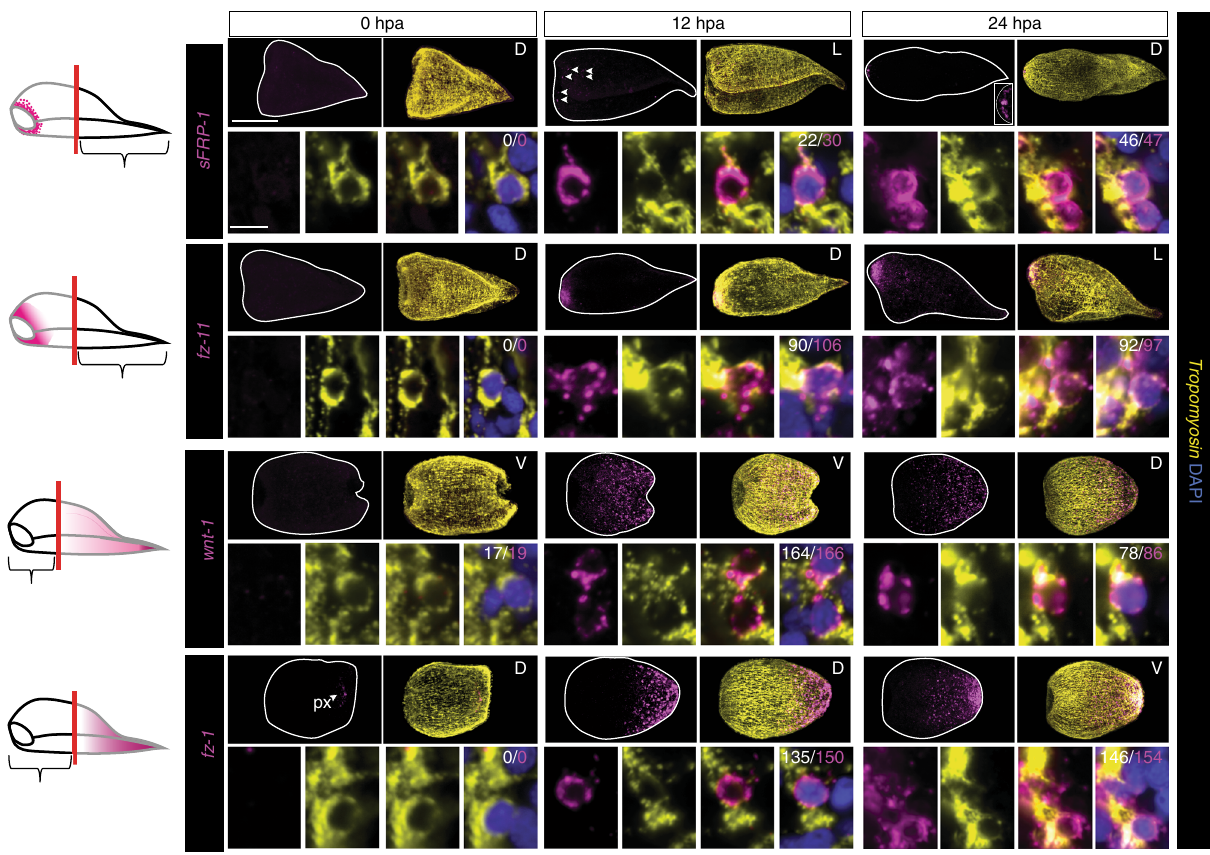
Fig. 4 PCGs are re-expressed in muscle during regeneration. Animals were amputated to remove expression zones of anteriorly or posteriorly restricted genes. In the schematic, the black outline represents the regenerating piece assayed; grey outline represents the piece removed. Successful removal of body wall expression region was veri fi ed by observation of PCG expression at the time of amputation (0 h post-amputation [hpa]). The fraction of PCG-positive cells that expressed tropomyosin was assayed at 12 and 24 hpa. Intact interior pharynx (px) expression was excluded from analysis. The denominator for each quanti fi cation is the total number of PCG-positive cells; the numerator is the total number of PCG/ tropomyosin double-positive cells. 100 μ m, overview image; 10 μ m, cell inset. D dorsal view, V ventral view, L lateral view. Overview images are representative of 5/5 animals